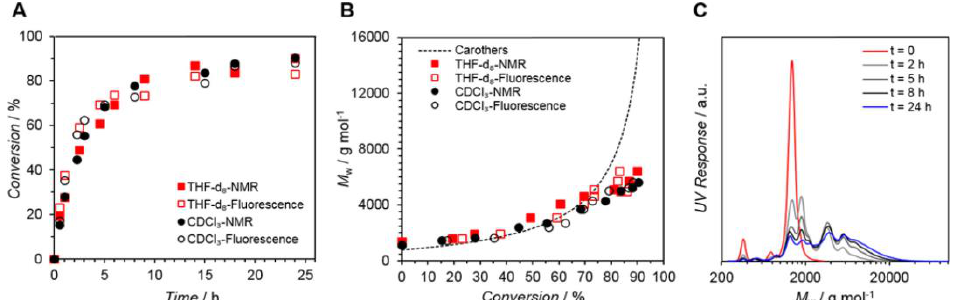
Figure 5. ( A ) Kinetic plot displaying conversion vs. reaction time for the polymerization of M1,2 (Solvents = THF-d8 or CDCl 3 . NMR (solid symbols) and fluorescence (open symbols) determined the conversion. ( B ) Corresponding Mw vs. conversion plot (Carothers curve represented as a dotted line). ( C ) Mw values determined via SEC analysis. Reproduced with permission from reference